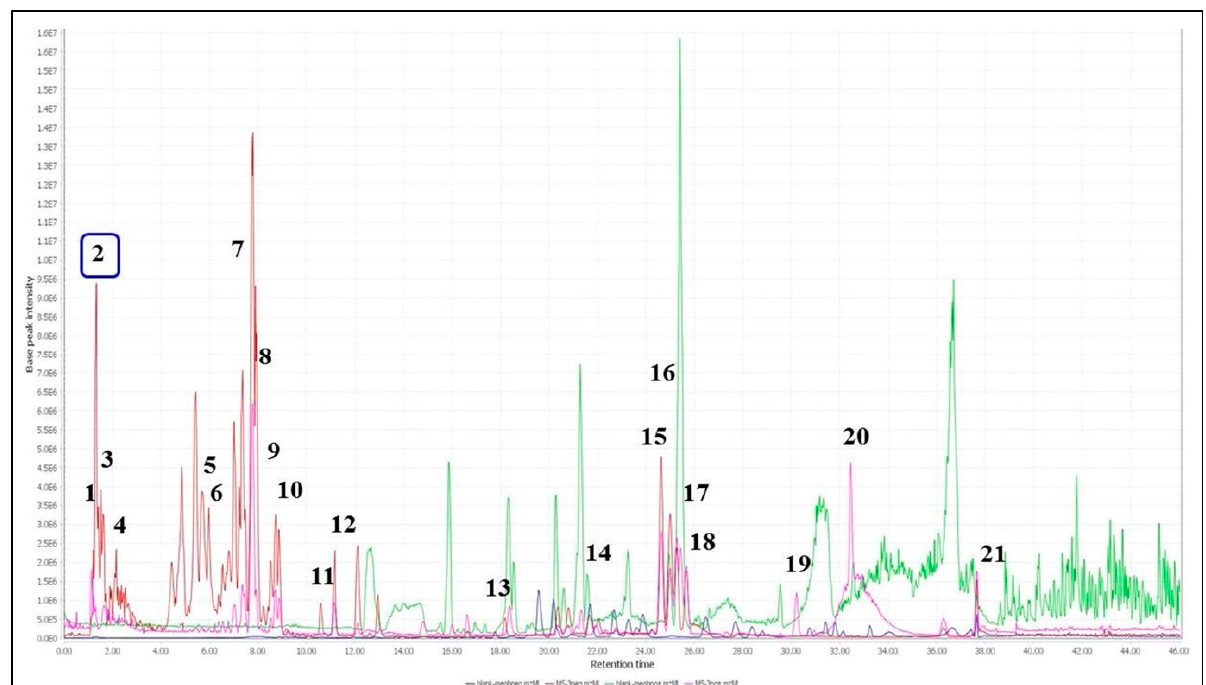
Figure 7. Total ion chromatogram of the extract of S. lanceolata (red and violet represent positive and negative ionization modes, respectively). Green and black peaks represent the methanol used in this analysis that acts as blank. The dereplication of numbered peaks is shown in Supplementary Table S2. E0: 1.0 × 10 0 ; E5: 1.0 × 10 5 ; E6: 1.0 × 10 6 ; E7: 1.0 × 10 7 .